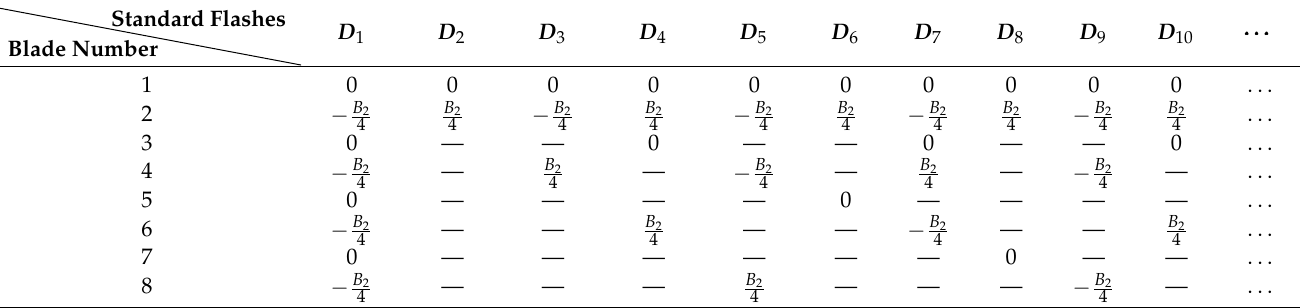
Table 1. The standard frequency dictionary.